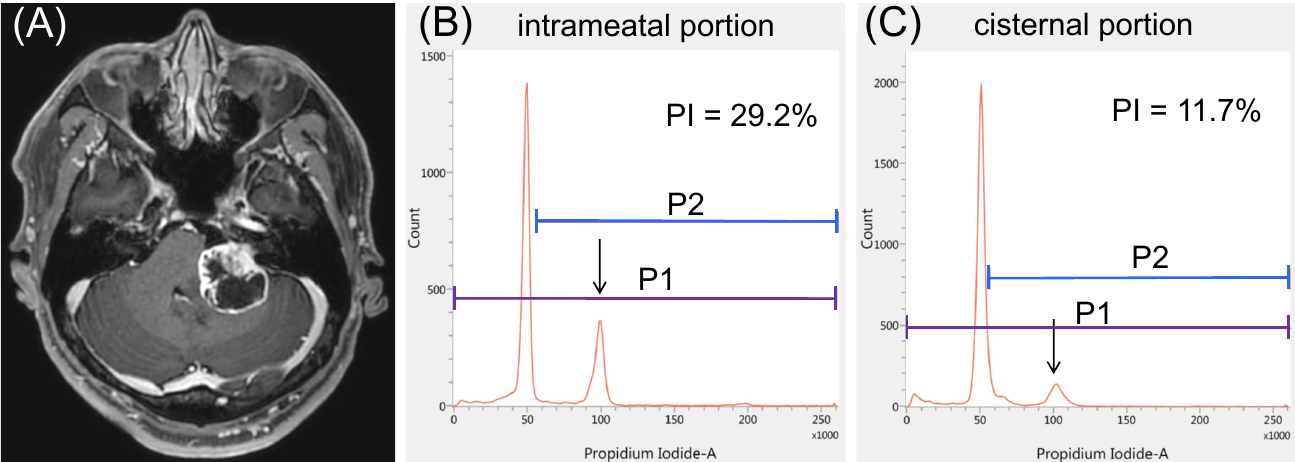
Figure 3. Illustrative case 1. ( A ) A representative case of vestibular schwannoma causing severe hearing loss. The proliferation index (PI) appears to be significantly higher in the ( B ) intrameatal portion than in the ( C ) cisternal portion: 29.2% vs. 11.7%. Arrows represent the peaks of tetraploid cells.